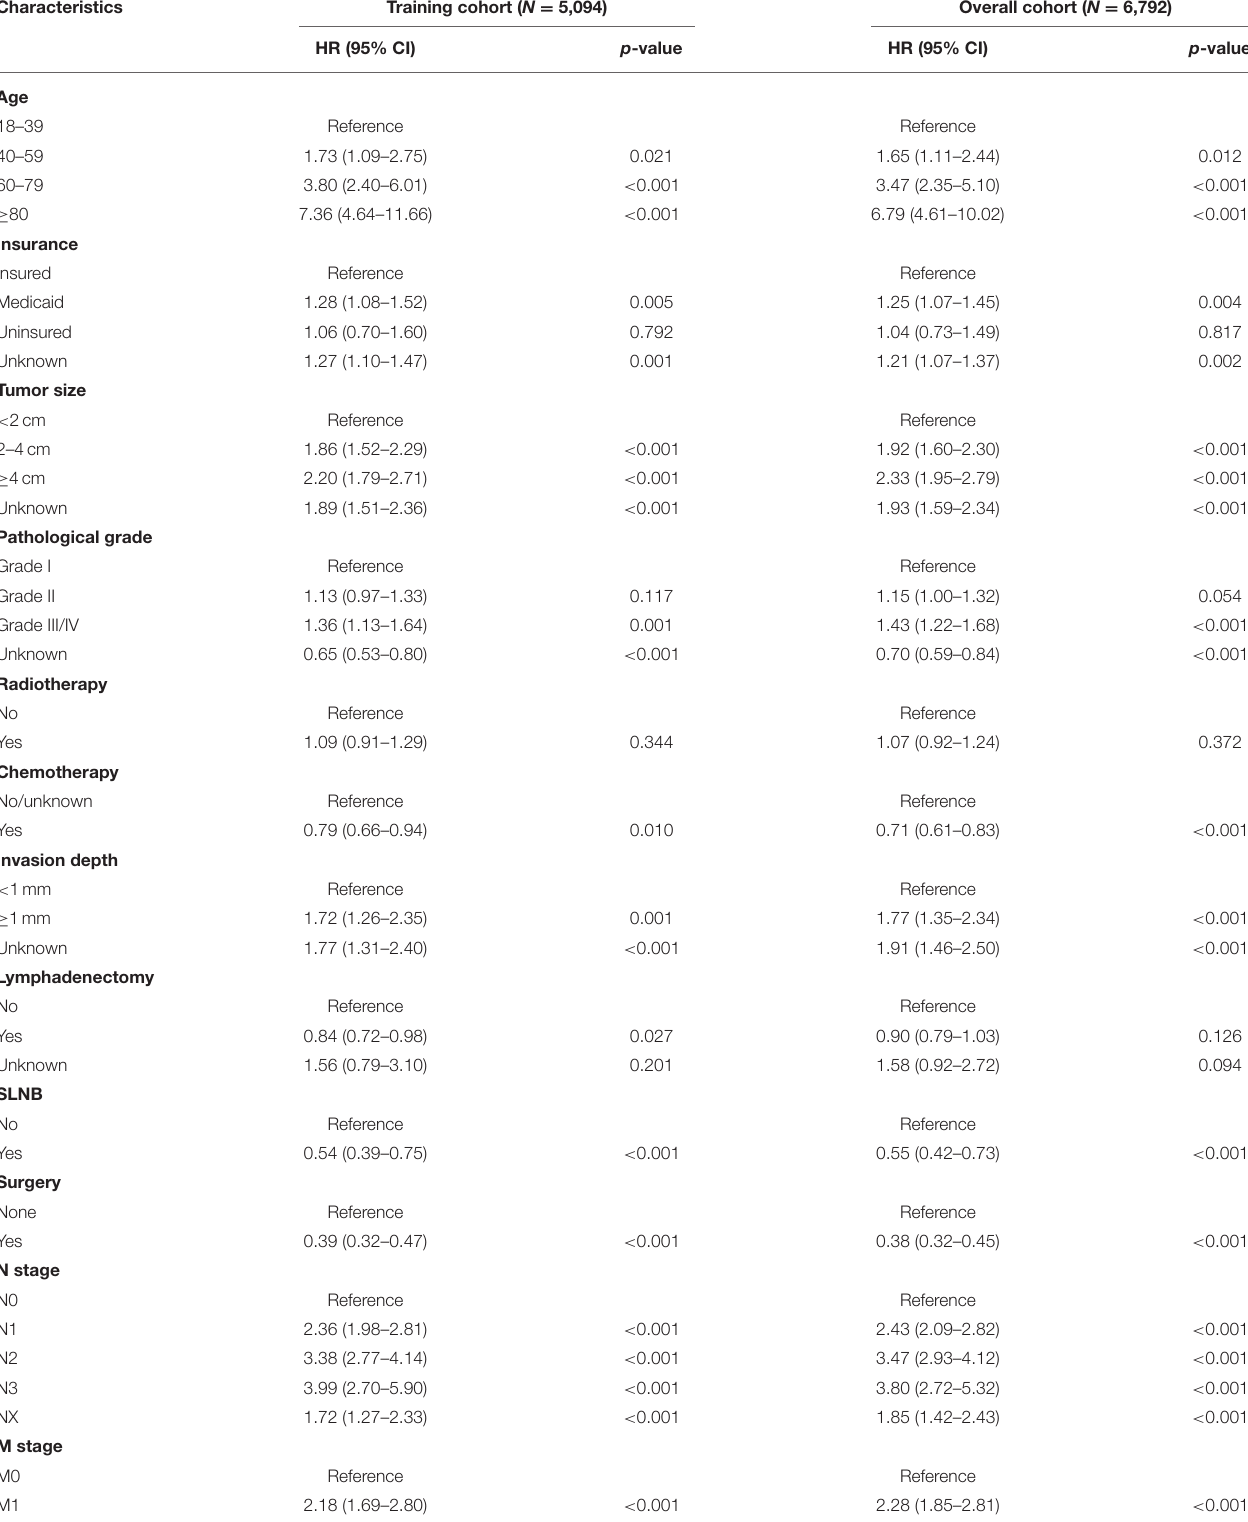
TABLE 3 | The results of multivariate cox proportional hazard risk model for cancer-specific survival (CSS).